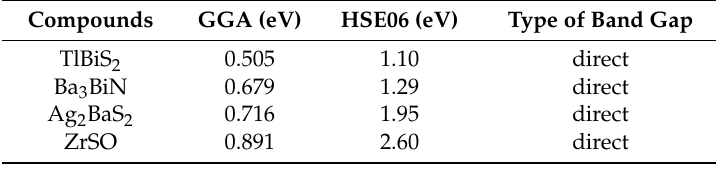
Table 1. Calculated GGA and HSE06 band gap values, type of band gap for TlBiS 2 , Ba 3 BiN, Ag 2 BaS 2 , and ZrSO phases.